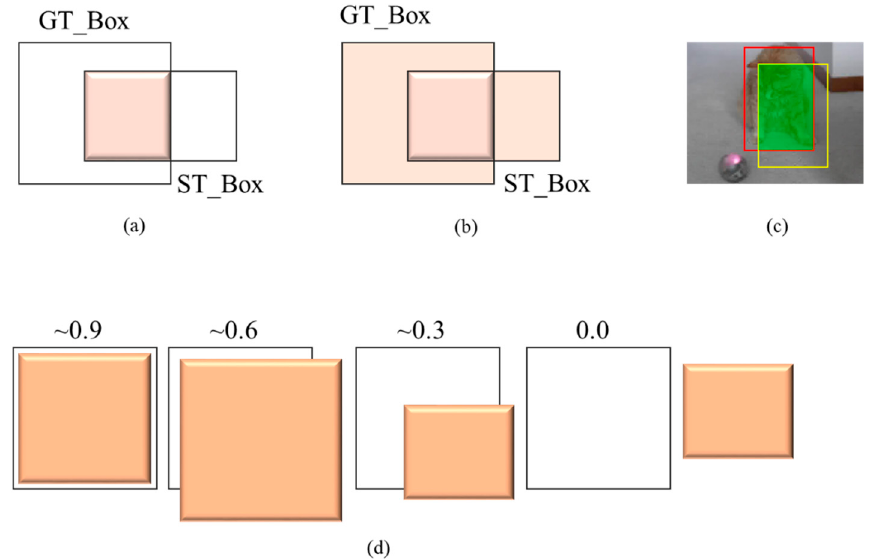
Figure 12. Calculation Method of Intersection Ratio Using Bounding Boxes. ( a ) Intersection, ( b ) Union, ( c ) Applied Image, ( d ) Numerical Change of Overlap Rate in the Overlap Region.